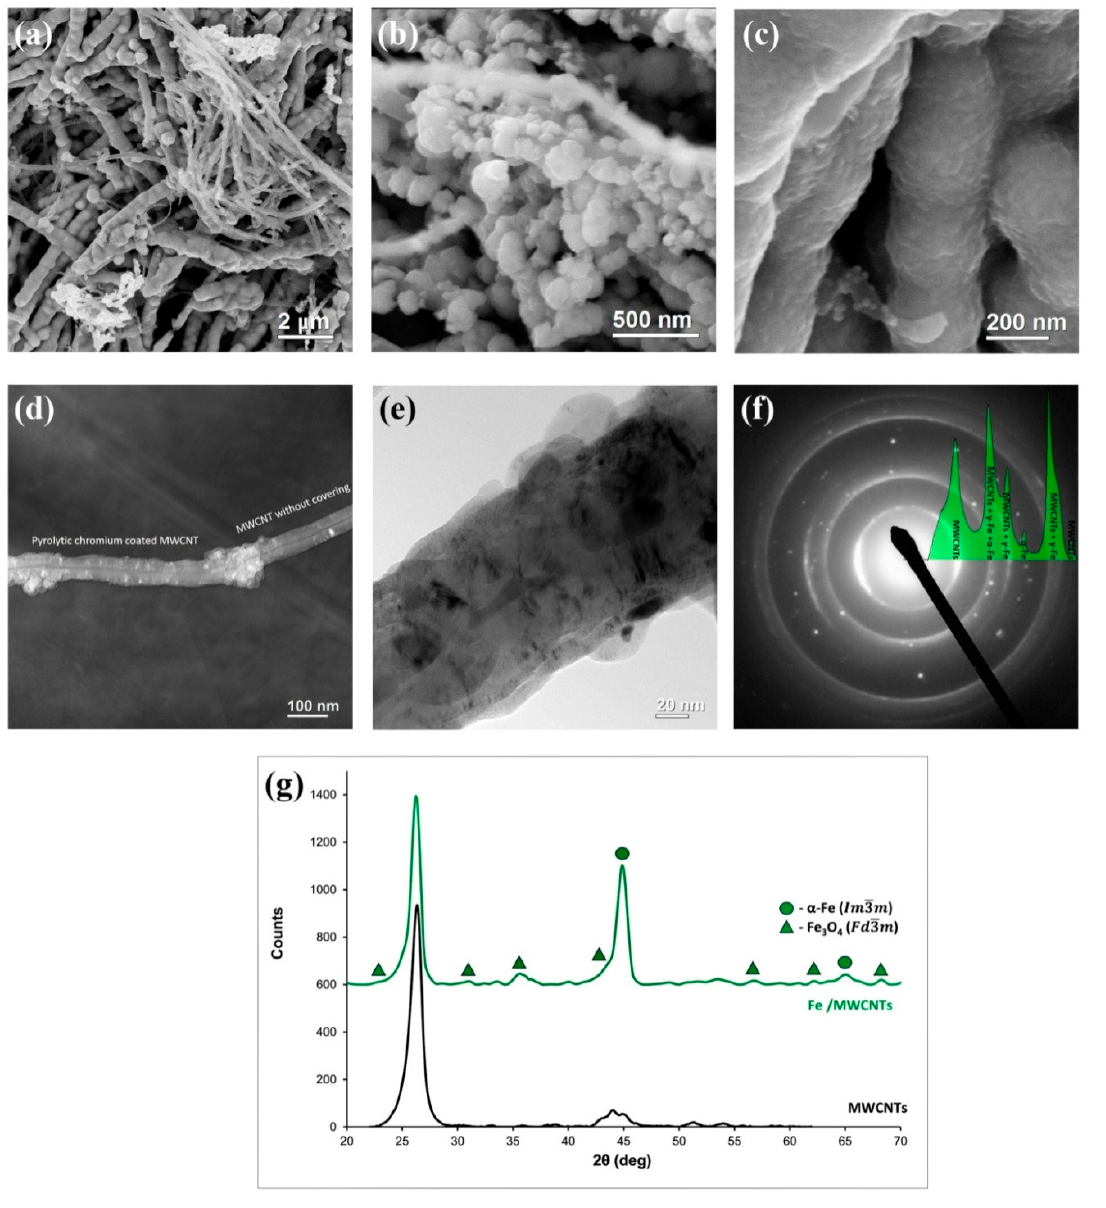
Figure 5. The Fe / MWCNTs nanocomposite research results: ( a – c ) SEM micrographs of the Fe / MWCNTs nanocomposite; ( d , e ) TEM images of the Fe / MWCNTs nanocomposite; ( f ) SAED with profile of azimuthal integration result; ( g ) XRD patterns of the initial MWCNTs (black) and Fe / MWCNTs nanocomposite (green).